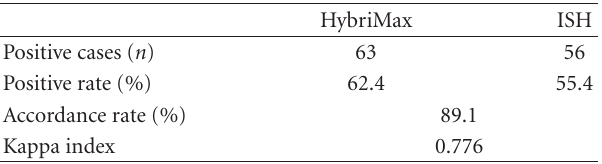
Table 2: The accordance of HybriMax and ISH for HPV 16/18 detection.